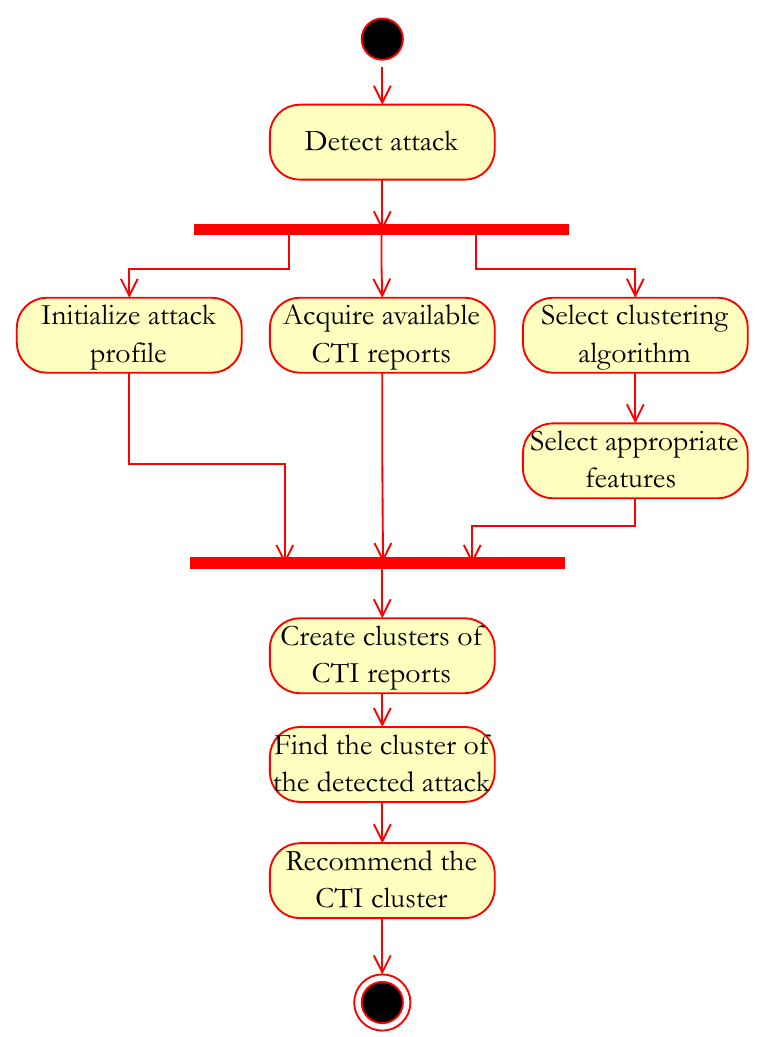
Figure 2. The activity diagram of the primary functionality (behavior) of